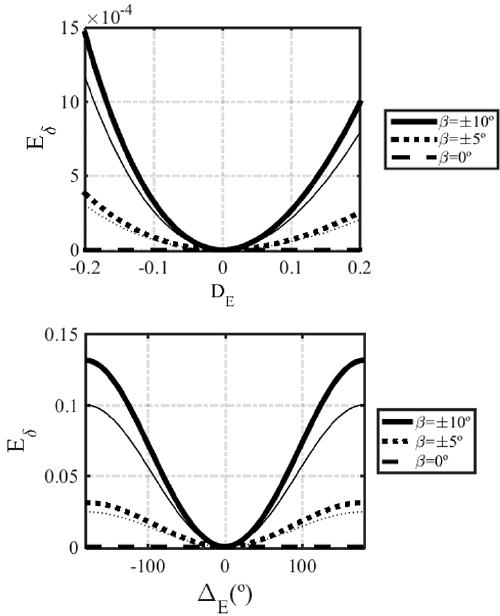
Figure 4. Simulated-to-real δ difference E δ over the diattenuation D E (top) and on the retardance (cid:49) E (bottom) of the emitter optics, for different misalignment angles ( β) . Thick and thin lines corre- spond to δ r values of 0.004 and 0.45, respectively.